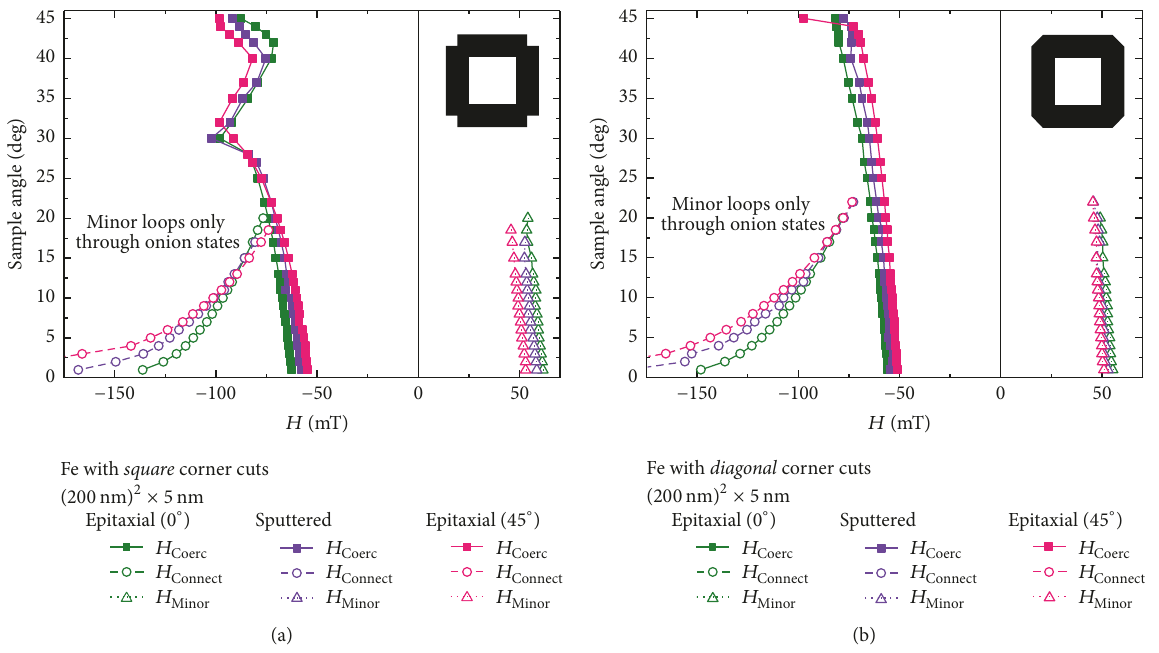
Figure 5: Phase diagrams of minor loops via onion states, simulated for nanorings with square corner cuts (a) and diagonal corner cuts (b). The fields 𝐻 Coerc , 𝐻 Connect , and 𝐻 Minor are explained in Figure